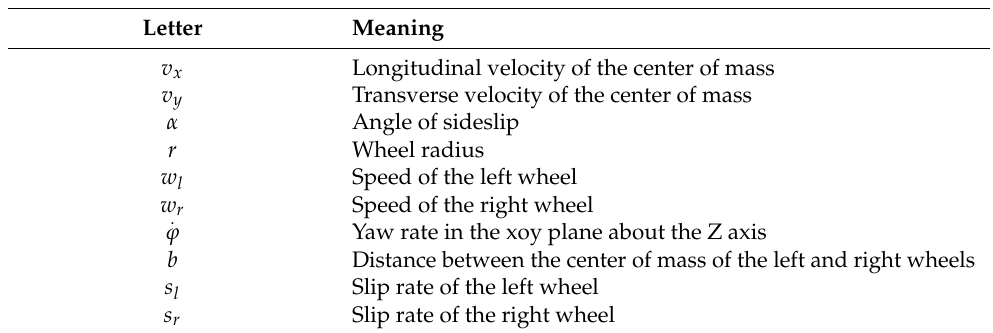
Distance between the center of mass of the left and right wheels Slip rate of the right